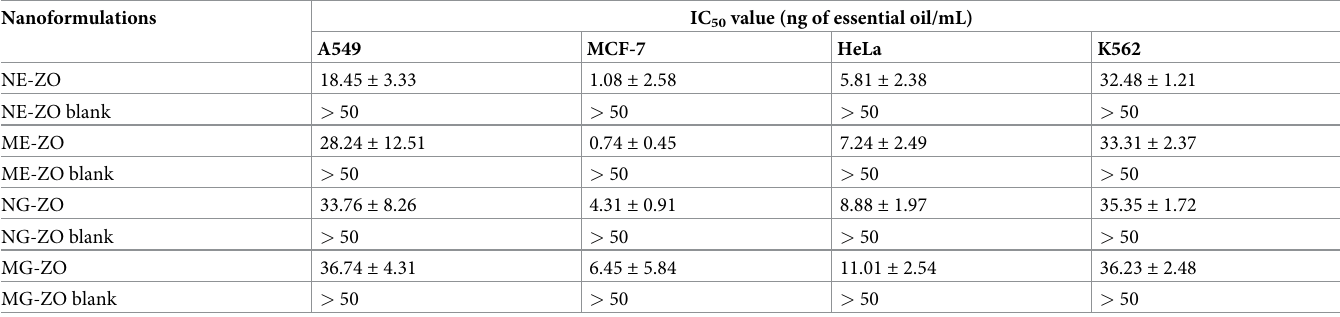
Data represent mean ± standard deviation (SD). The dataset is available in S8 − S11